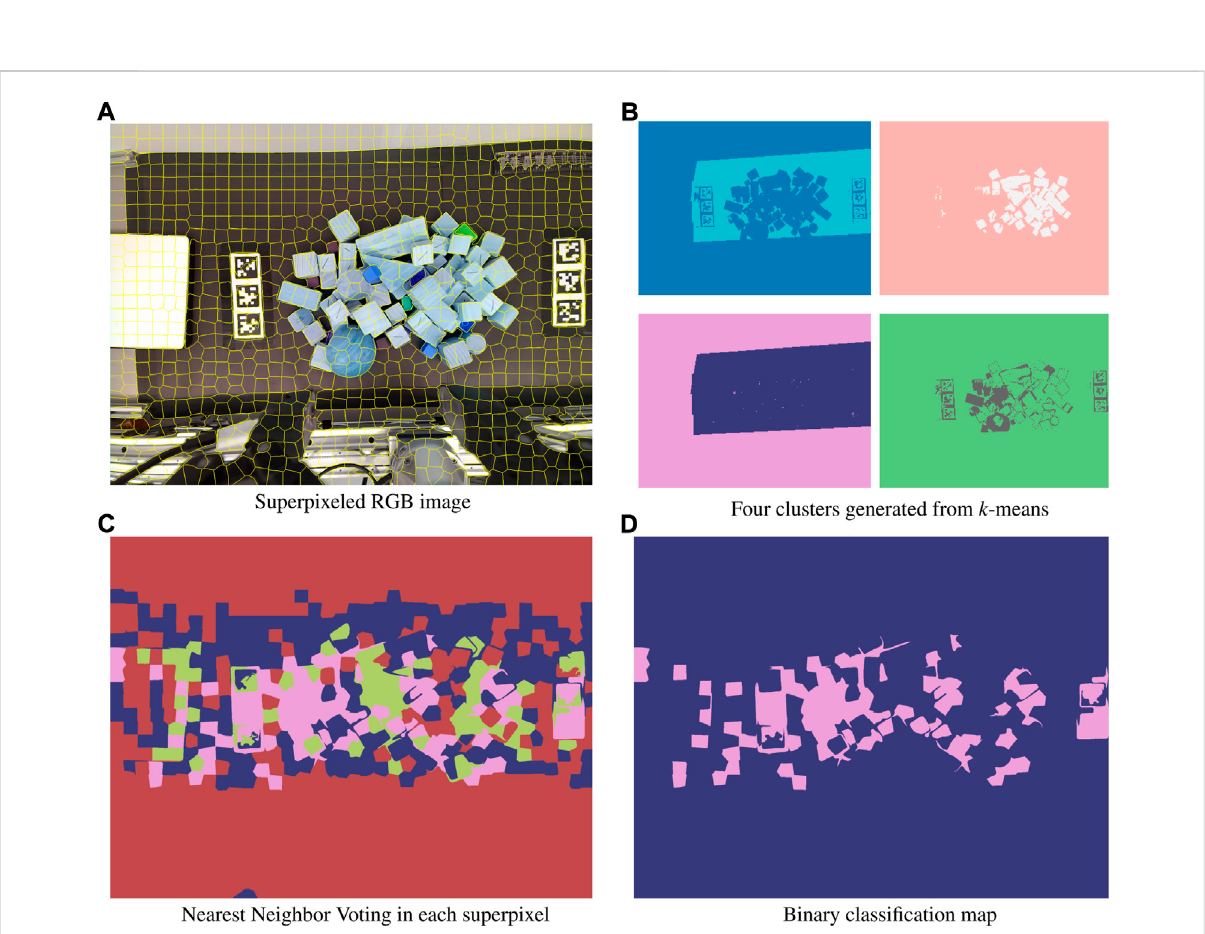
FIGURE 6 The process of cautiously creating de fi nitively pure data to train the AE is as follows: First, superpixeling is used to split the RGB image into characteristic regions (A) . k-means segmentation in abundance classes from the hyperspectral datacube is applied to segment the associated RGB- HSI data into four clusters (B) . The dominant cluster within each superpixel, biased to favor potentially anomalous regions, is identi fi ed (C) . This information is then used to create a binary classi fi cation map, with the two labels being pure regions and potentially anomalous regions, the latter of which is excluded in the autoencoder training process (D)